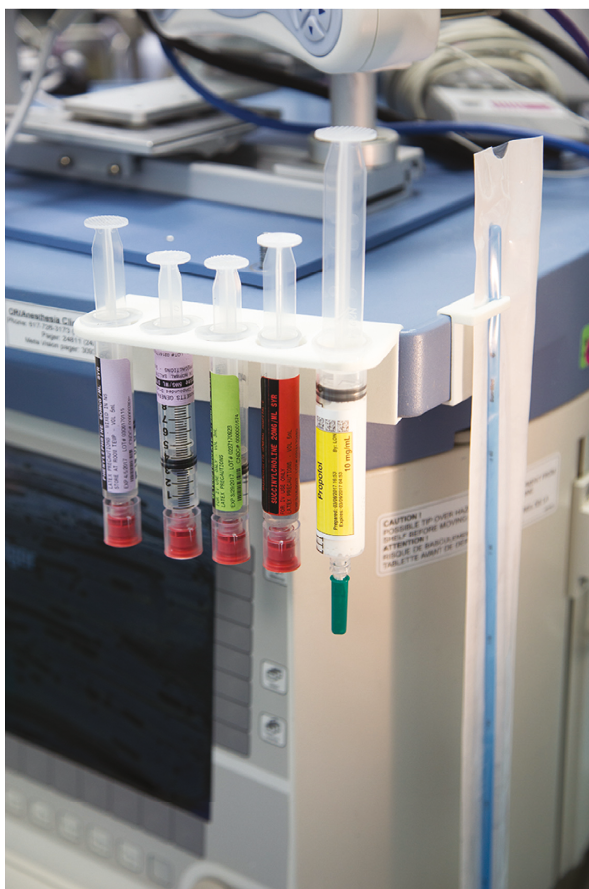
Figure 3: Final selective laser-sintering 3D-printed bracket and accompanying bougie holder in use. The bracket clips securely to the corner of the anesthesia machine and accepts five 10–20mL BD syringes (standard setup including phenylephrine, ephedrine, glycopyrrolate, succinylcholine, and propofol